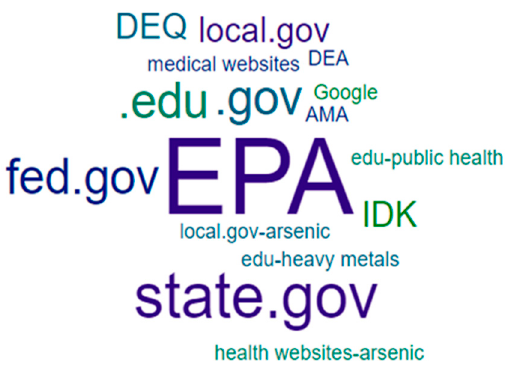
Figure 3. Community-identified sources of reliable information.